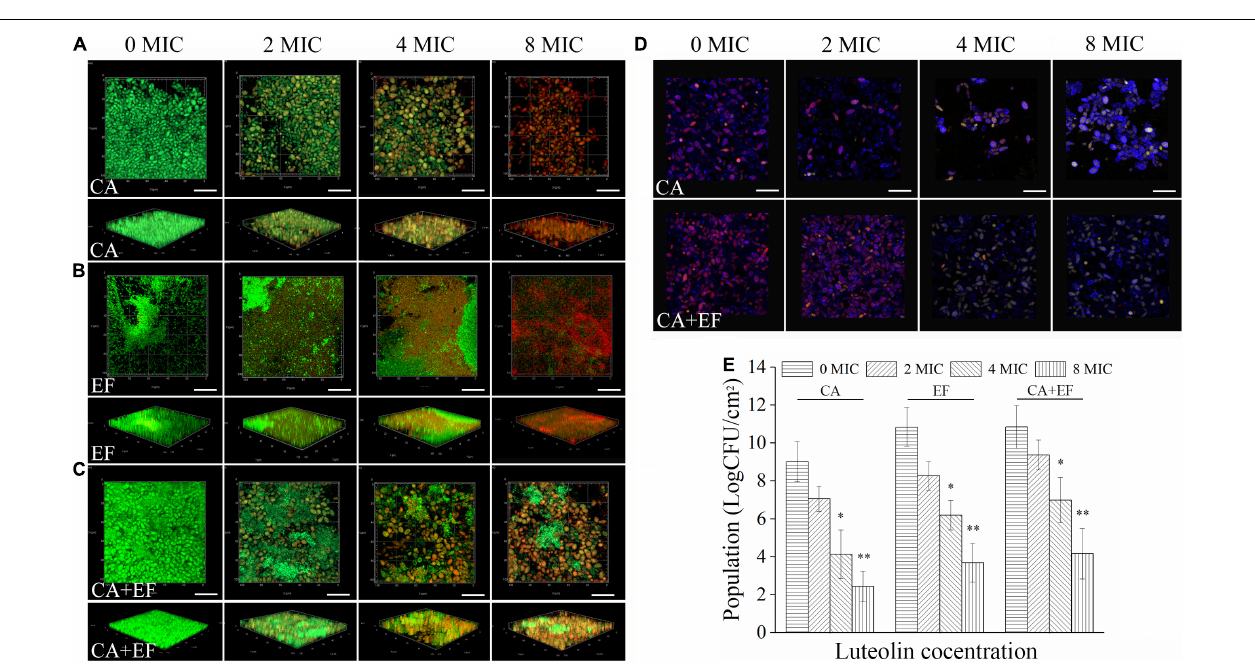
the findings of CLSM in combination with live/dead staining with SYTO 9 and